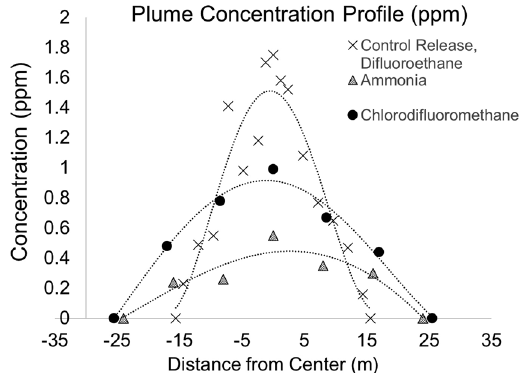
Figure 6. Estimation of plume concentration based on column density spectra. The concentration profiles shown in this Figure are for horizontal slices through the centers of the plumes seen in Fig. 4 (frame 2) and Fig. 7.